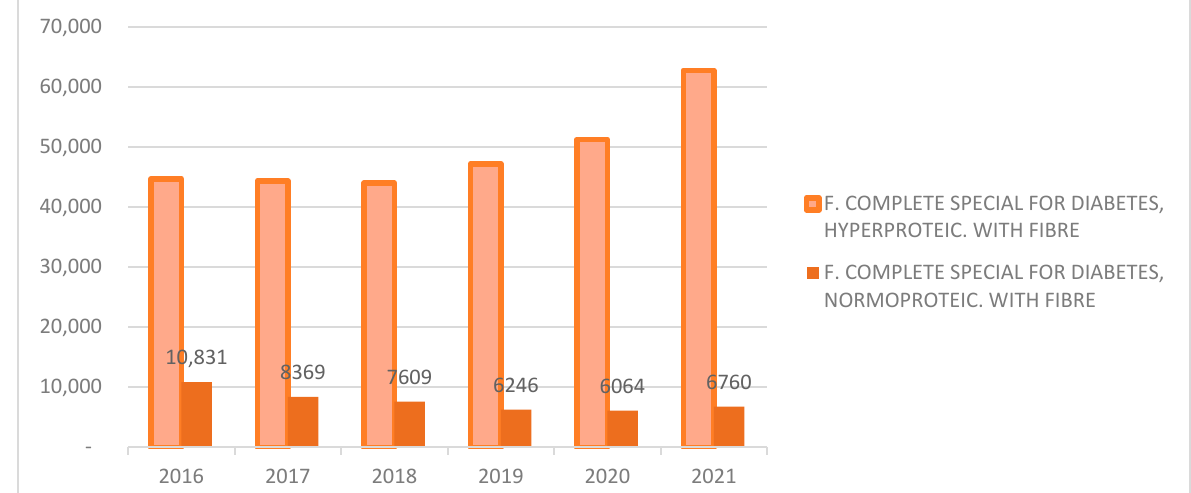
Figure 4. Number of total consumed packages of diabetic diet therapeutic products from 2016 to 2021 in the Community of Madrid.